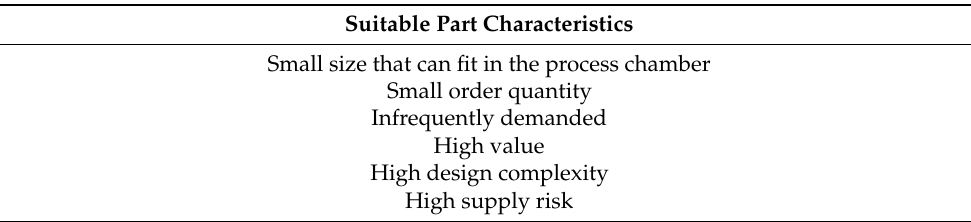
Table 2. Suitable part characteristics for 3D printing for the maritime